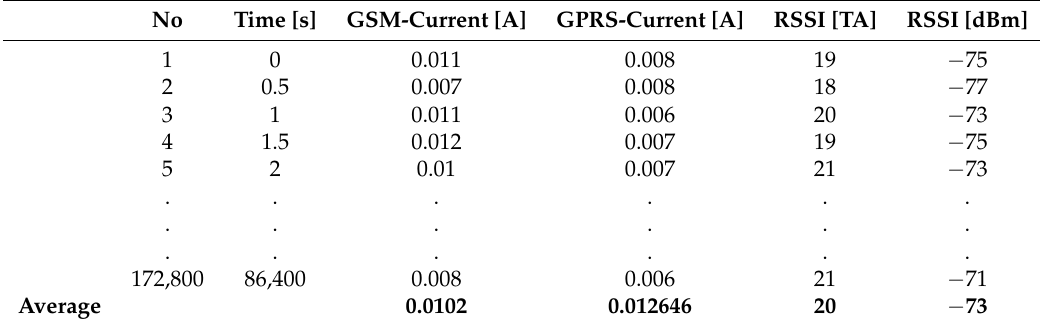
Table 7. Current consumption in location 4, RSSI = − 73 dBm.